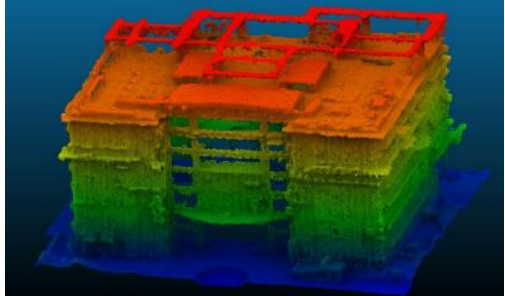
Figure 8. Processed LAS files for flight observations Mar. 05, 2017